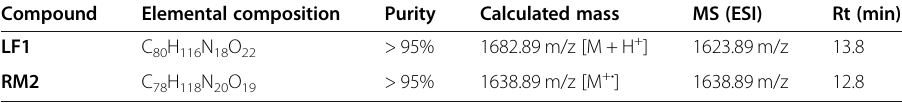
Table 1 Analytical data of LF1 and RM2 Compound Elemental